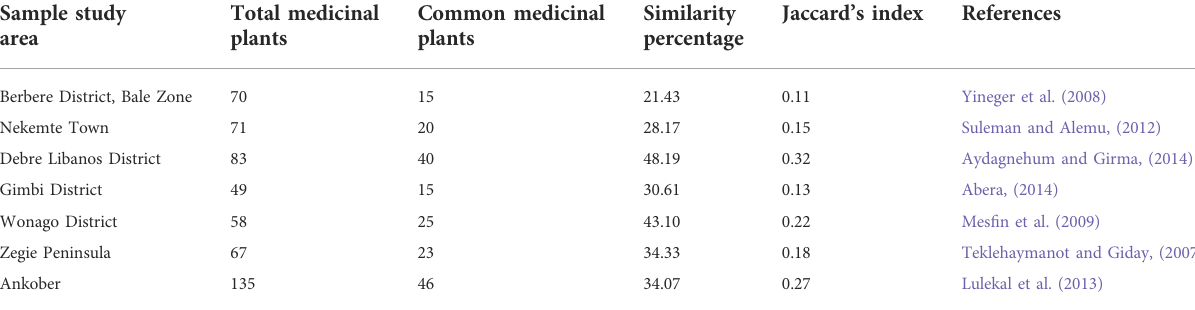
TABLE 4 Jaccard ’ s Coef fi cient of Similarity index with six other areas with respect to plants species composition. Sample study